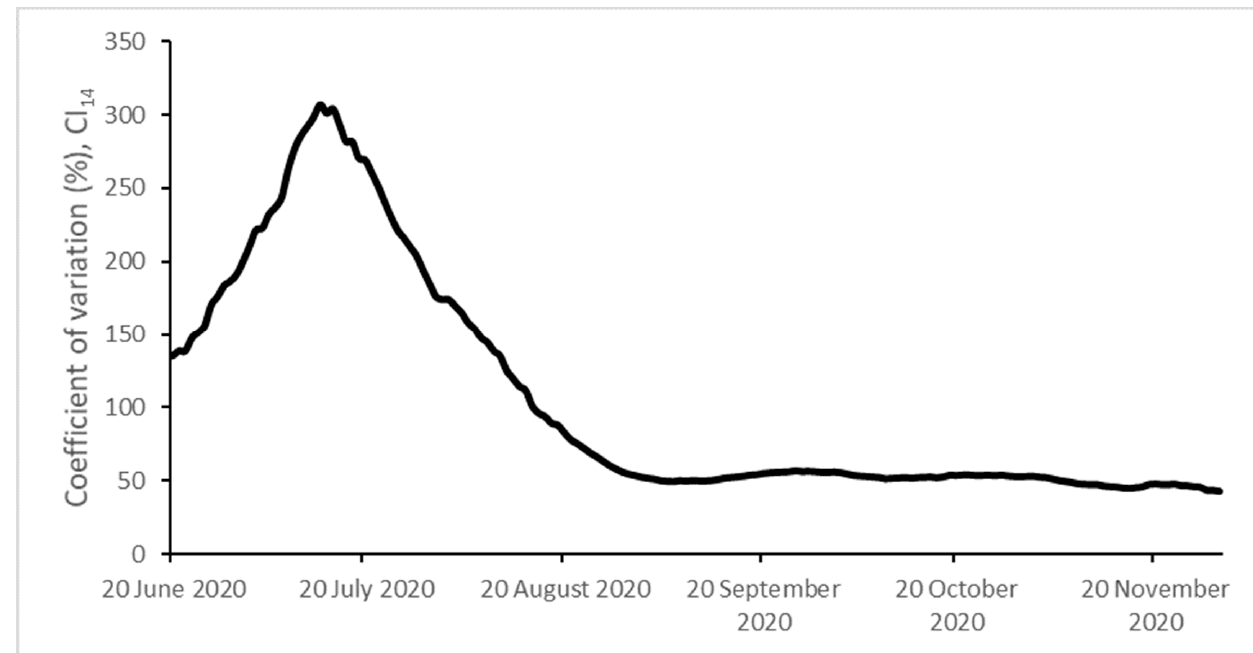
Figure 2. σ -Convergence. Coefficient of